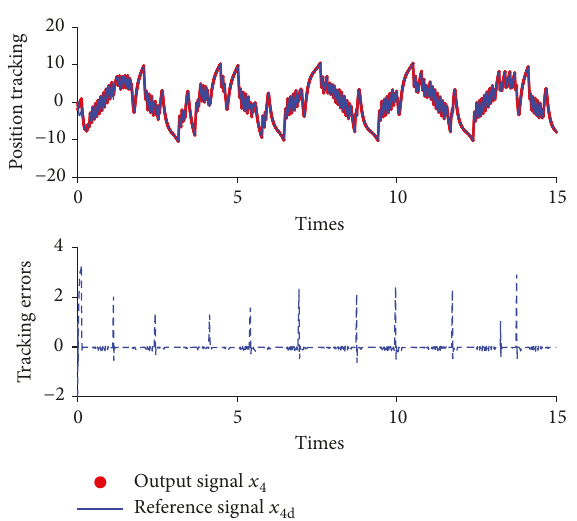
Figure 11: The control results and tracking error of x 2 8 sin 2/3 π t